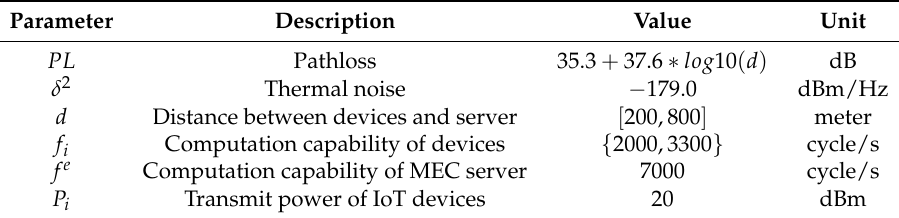
Table 1. The parameters of Internet of Things (IoT) devices and mobile edge computing (MEC) server Parameter